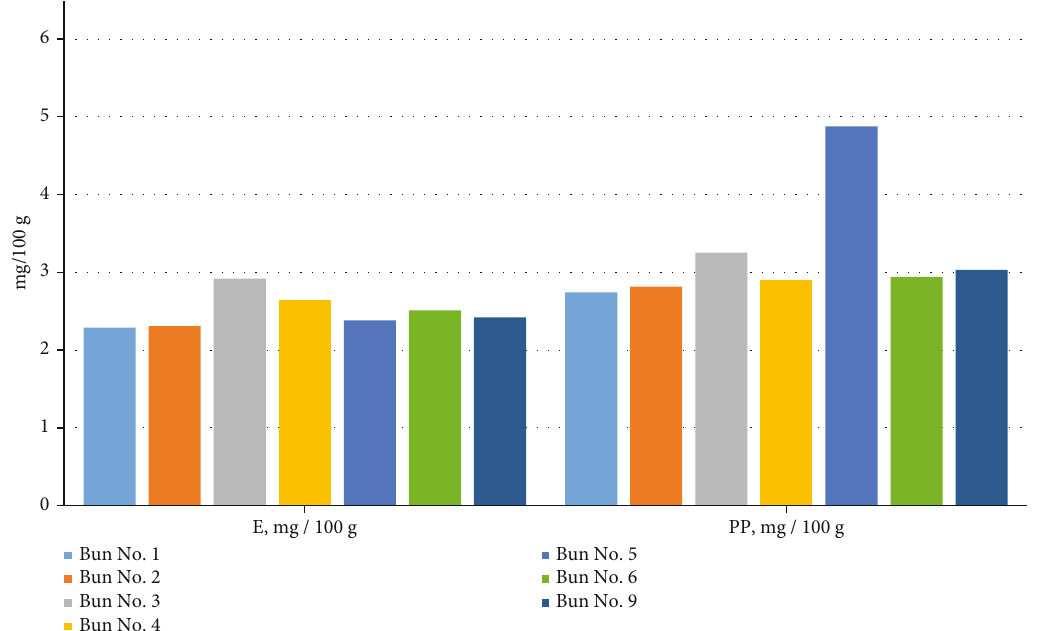
Figure 17: The content of vitamins E and PP in the various bun formulations.